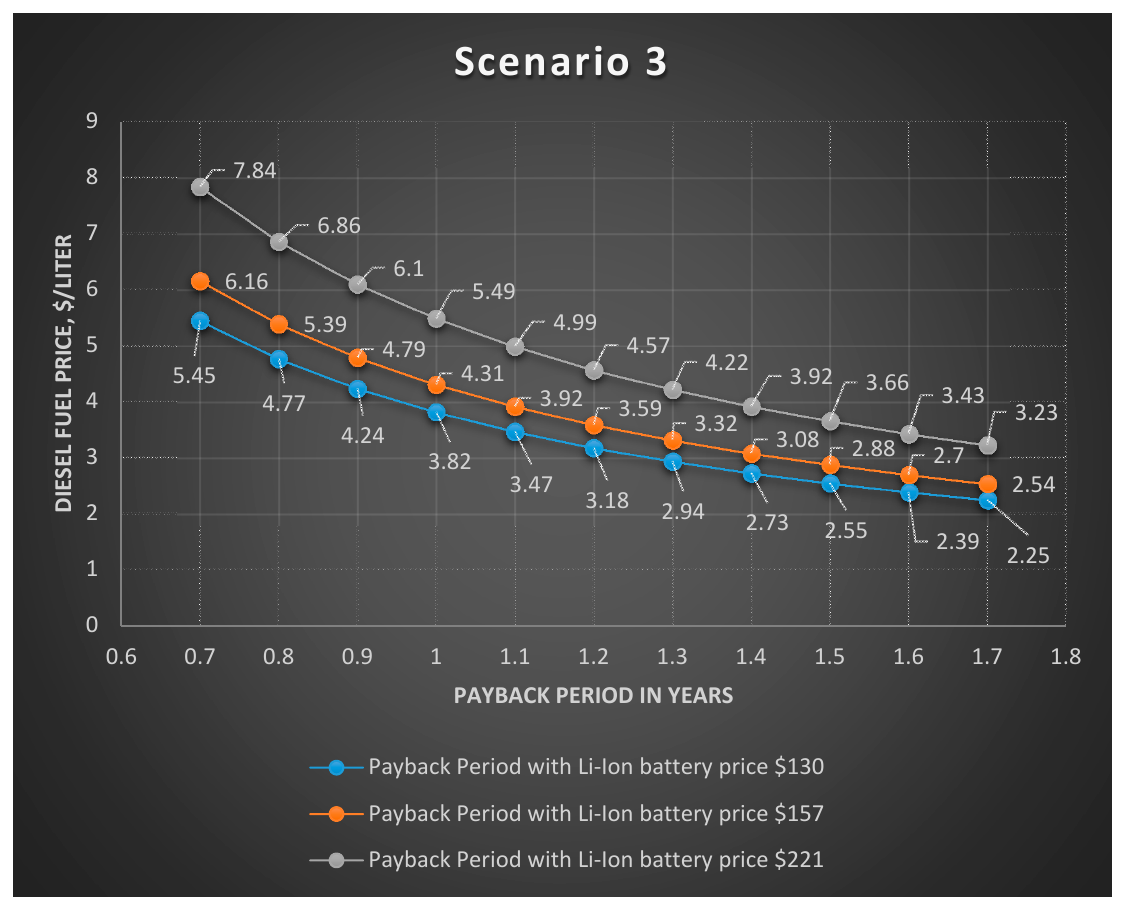
Figure 10. Fuel savings, payback time, and working time for 30%L + 50%L + 60%L + 80%L fixed for 2.5 h.